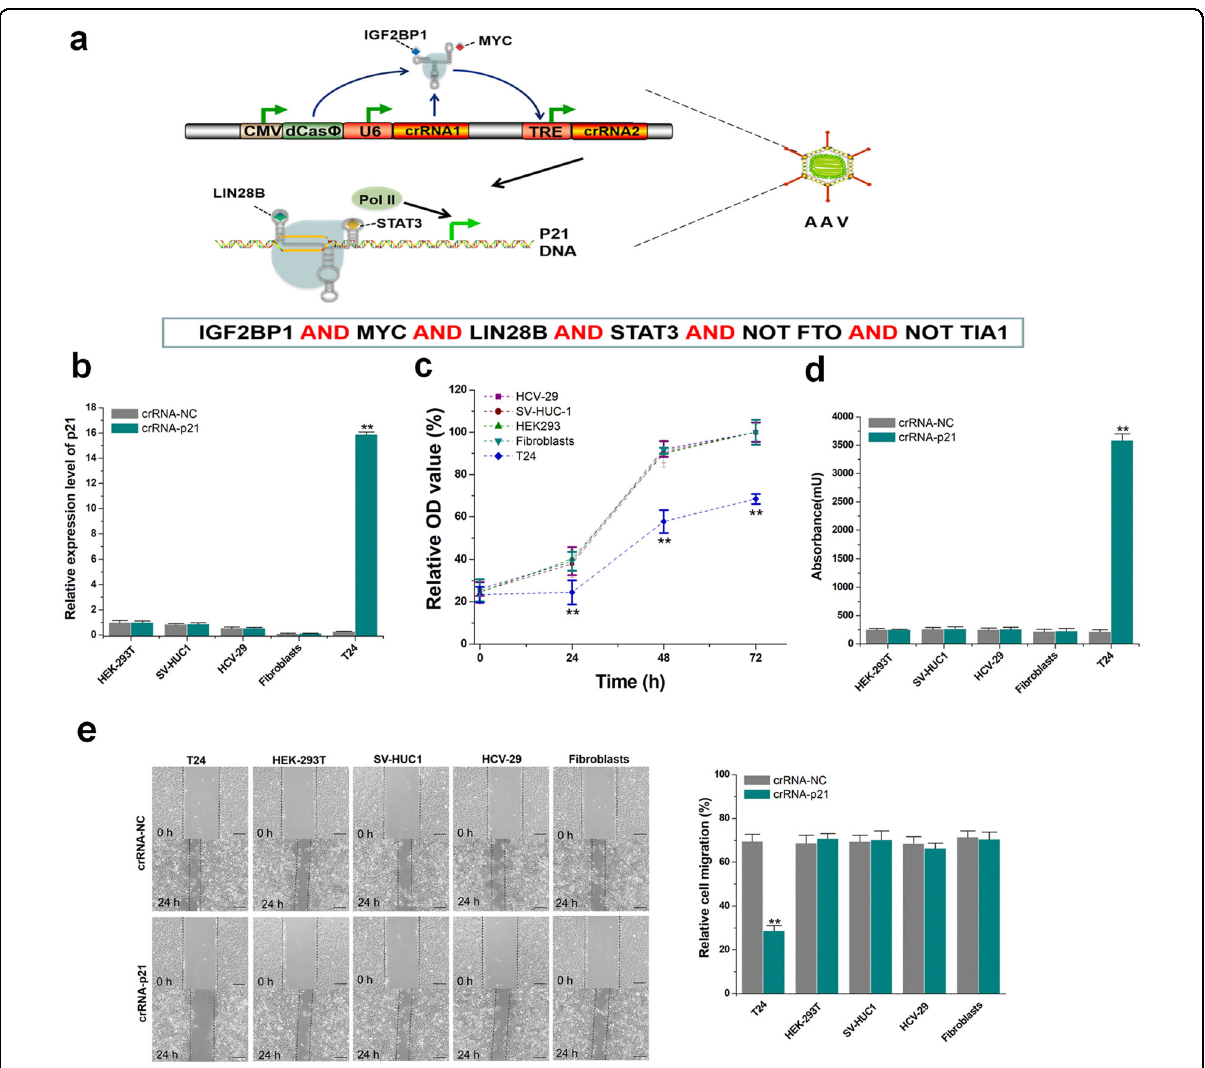
Fig. 7 Speci fi c recognition and inhibition of cancer cells through the AAV-logic gate. a Schematic diagram of the six-input logic gate delivered by AAV. b Changes in the relative expression levels of p21 in cancer and normal cells. The relative expression levels of p21 were determined by qPCR 48 h after AAV transduction. c Proliferation of transduced cells was determined by CCK-8 assay at different time points. Relative optical density (OD) values (%) in each group were determined by comparison with the crRNA negative control. d The level of cell apoptosis was calculated by performing the Cell Death Detection ELISA assay. e Migration of transduced cells was measured by wound healing assay. Relative cell migration (%) in each group was determined by the migration distance normalized to that of the crRNA negative control group. The reported data represent the means ± SD from fi ve independent experiments. * P < 0.05; ** P < 0.01 between the groups using a two-tailed t